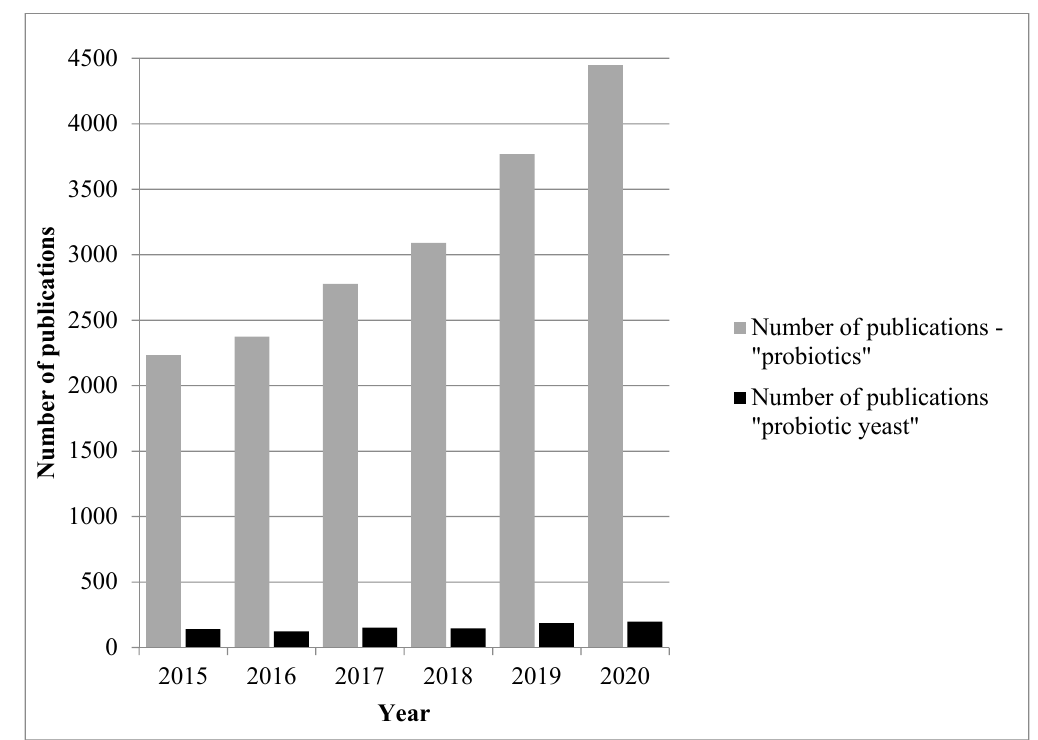
Figure 1. Number of PubMed publications under the terms “probiotics” and “probiotic yeast” in the last 5 years.